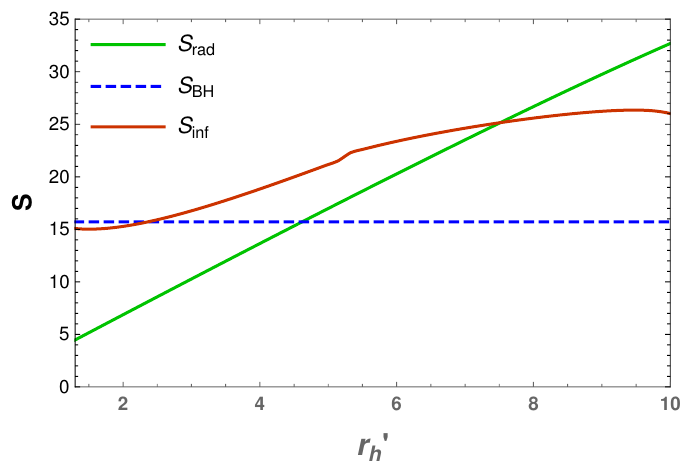
Figure 6. The Page curve according to eq. (2.18). We take r h = 10 , G N = 1 , ‘ = 1 and ˆ c = 0 . 2 . The green curve indicates the entropy of the radiation subsystem R 1 which continues to grow. Dashed blue curve is the entropy corresponding to the real black hole horizon which stays constant. The brown curve corresponds to the infalling geodesics which goes through the EoW brane from inception side to the real side and contains the island region partially. The intersection of green curve and dashed blue curve marks the Page time whereas the intersection of brown and green curve is termed as secret-sharing time. The colors are according to the figure